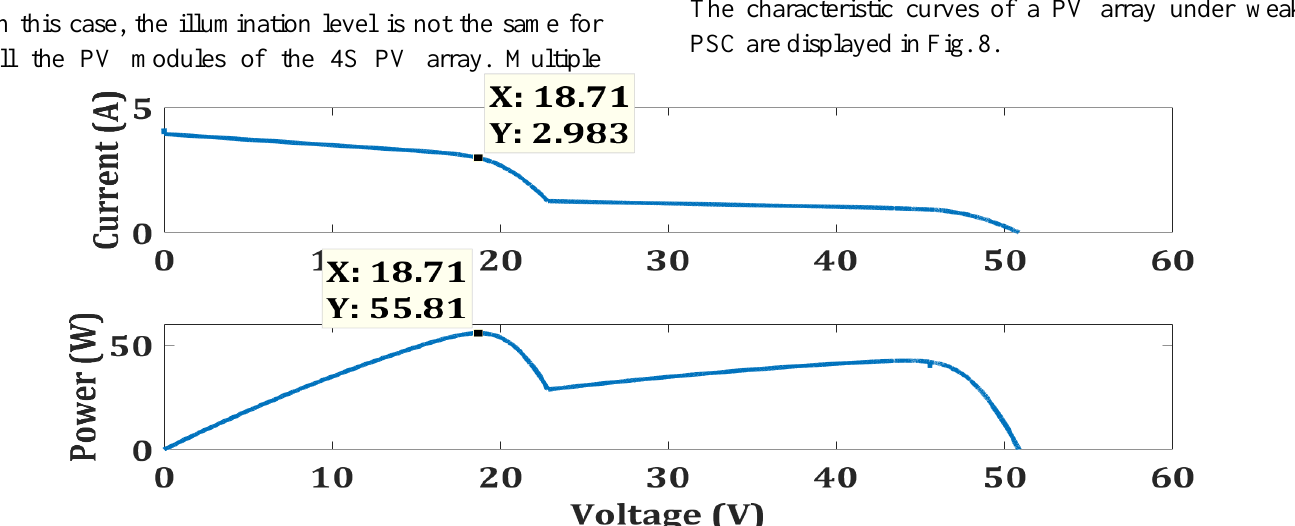
Fig. 7. Performance Comparison of FPA and AFPA Algorithms for Zero Shading